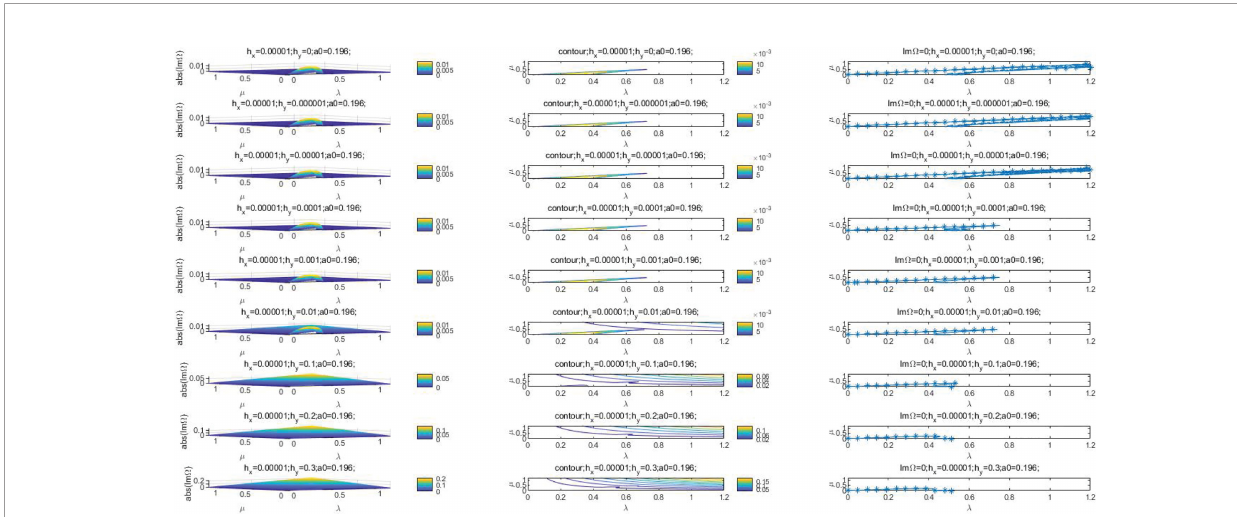
FIGURE 3 | Curves of ǀ Im W ǀ and Im W = 0 for a 0 = 0.196 and ∂ h ∂ x = 0 : 00001.